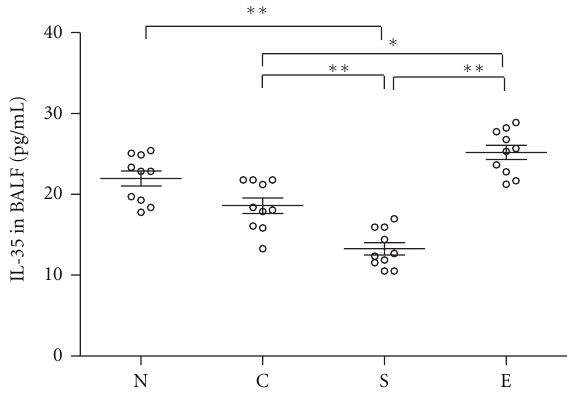
Figure 5: Treatment with erythromycin increases the levels of IL-35 in the lungs of rats. The levels of IL-35 in BALF of individual rats were analyzed by ELISA. Data shown are mean values of individual samples from three separate experiments and mean values (lines) of each group of rats ( n = 10). Group N: rats exposed to regular air without any special treatment; Group C: rats exposed to regular air and were treated with erythromycin; Group S: rats exposed to smoking air and were treated with saline; and Group E: rats exposed to smoking air and were treated with erythromycin daily for nine weeks beginning at the forth weeks smoking. ∗ P < 0 . 05, ∗∗ P < 0 .